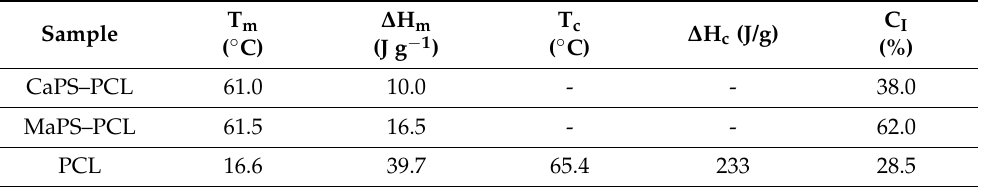
Table 2. Crystallization temperature (Tc), melting enthalpy ( ∆ Hc), and percentage of crystallization (C I ) of PCL, MaPS–PCL, and